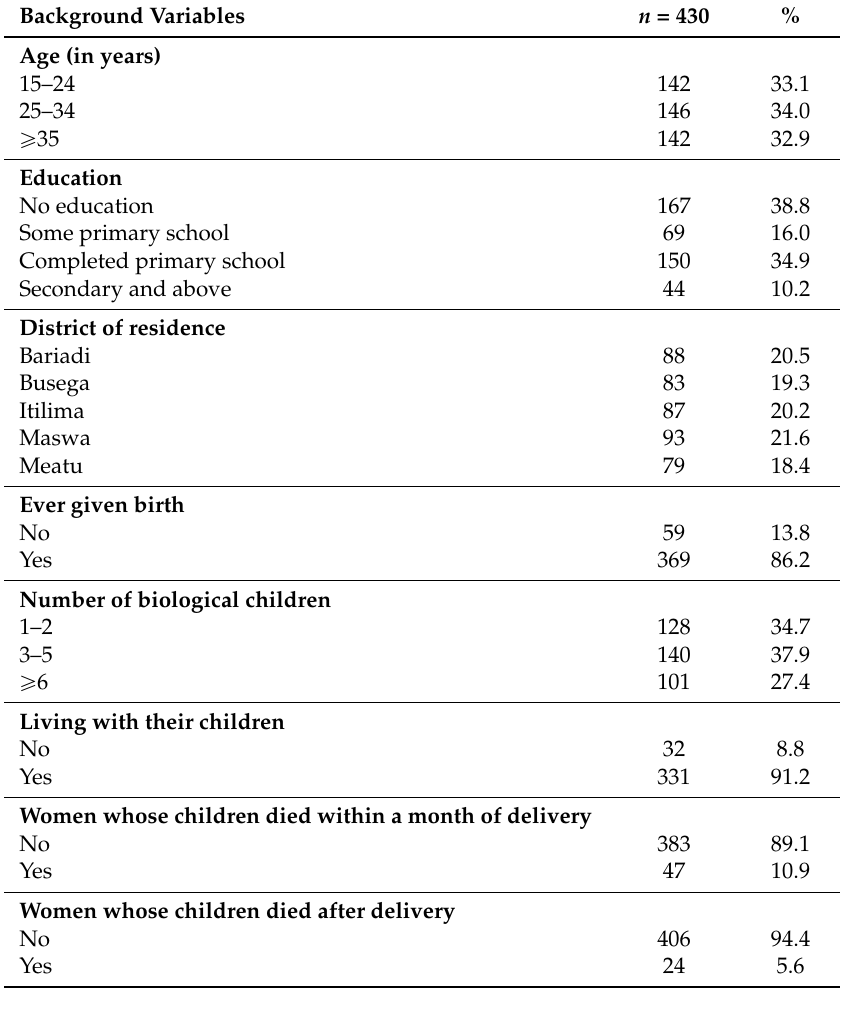
Table 1. Socio-demographic characteristics of participants in Smiyu region in